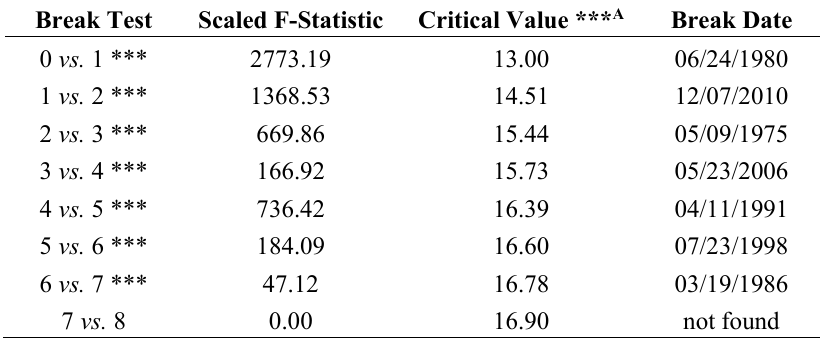
Table 4. Results for the Bai-Perron sequential test for structural breaks.